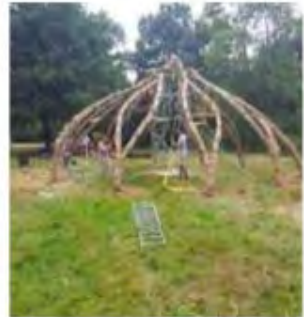
Figure 11. Structure after completion (”Turn Over a New Leaf”, 2013)